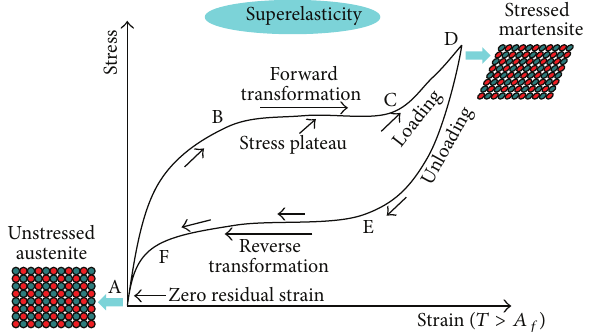
Figure 1: Hysteresis loop of superelastic shape memory alloy (SMA)